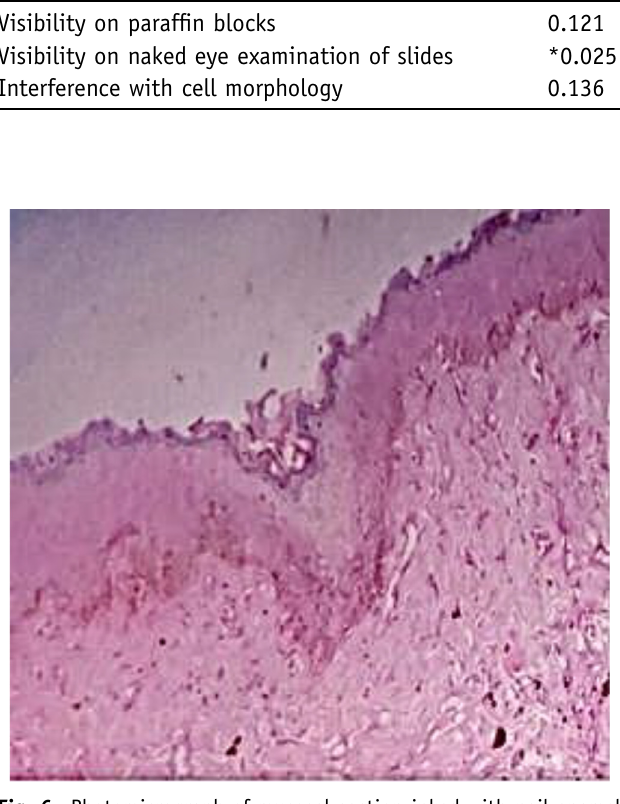
Fig. 6. Photomicrograph of mucosal section inked with nail enamel interfering with cellular